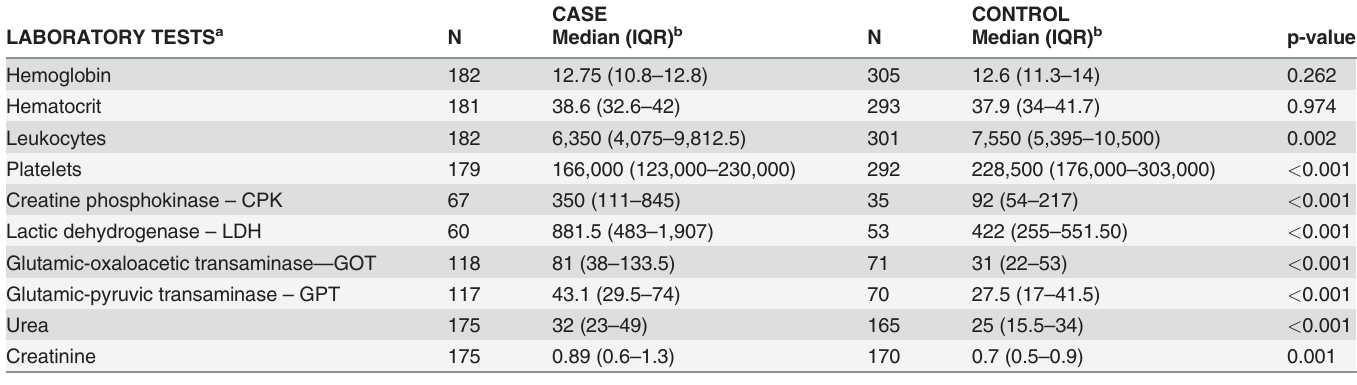
Table 3. Laboratory tests of patients hospitalized due to in fl uenza A(H1N1)pdm09 associated with Severe Acute Respiratory Illness, who died (case) or recovered (control), metropolitan regions of S ã o Paulo and Campinas, state of S ã o Paulo, Brazil, 2009.